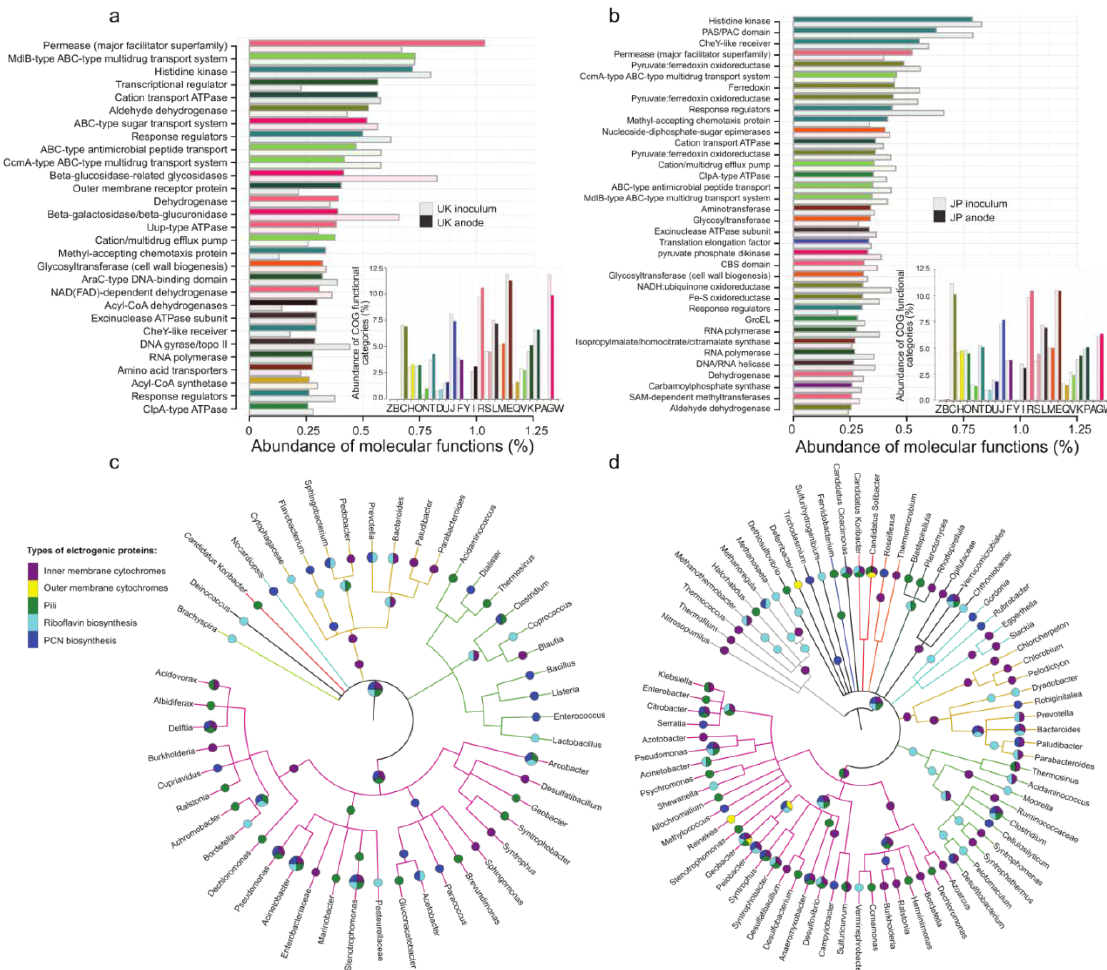
Figure 3: Functional profile of MFC microbiomes, and distribution of different types of proteins involved in electron transduction to anode among different phylogenetic groups on anodic biofilm. (a,b) Representation of the most abundant orthologous groups in the anode biofilm, represented by at least by 0.25% in (a) UK MFC or (b) JP MFC as determined by assignment to the COG database by MG-RAST. Orthologous groups are colored by their representative functional category, translucent bands represent the abundance in corresponding reference metagenomes. (c,d) Distribution of homologous of known proteins involved in extracellular electron transfer determined by BLAST (similarity 45%, E-value 10 -5 , alignment length at least 60 aa) plotted on NCBI taxonomy tree for (c) UK MFC and (d) JP MFC. Branches are colored according to the phylum level, circles on the branches indicate the presence of particular type of proteins in this phylogenetic group. For detailed information see Table S10. A key to the COG letter codes for functional categories can be found in Table S7, a detailed description for particular COG can be found in Table